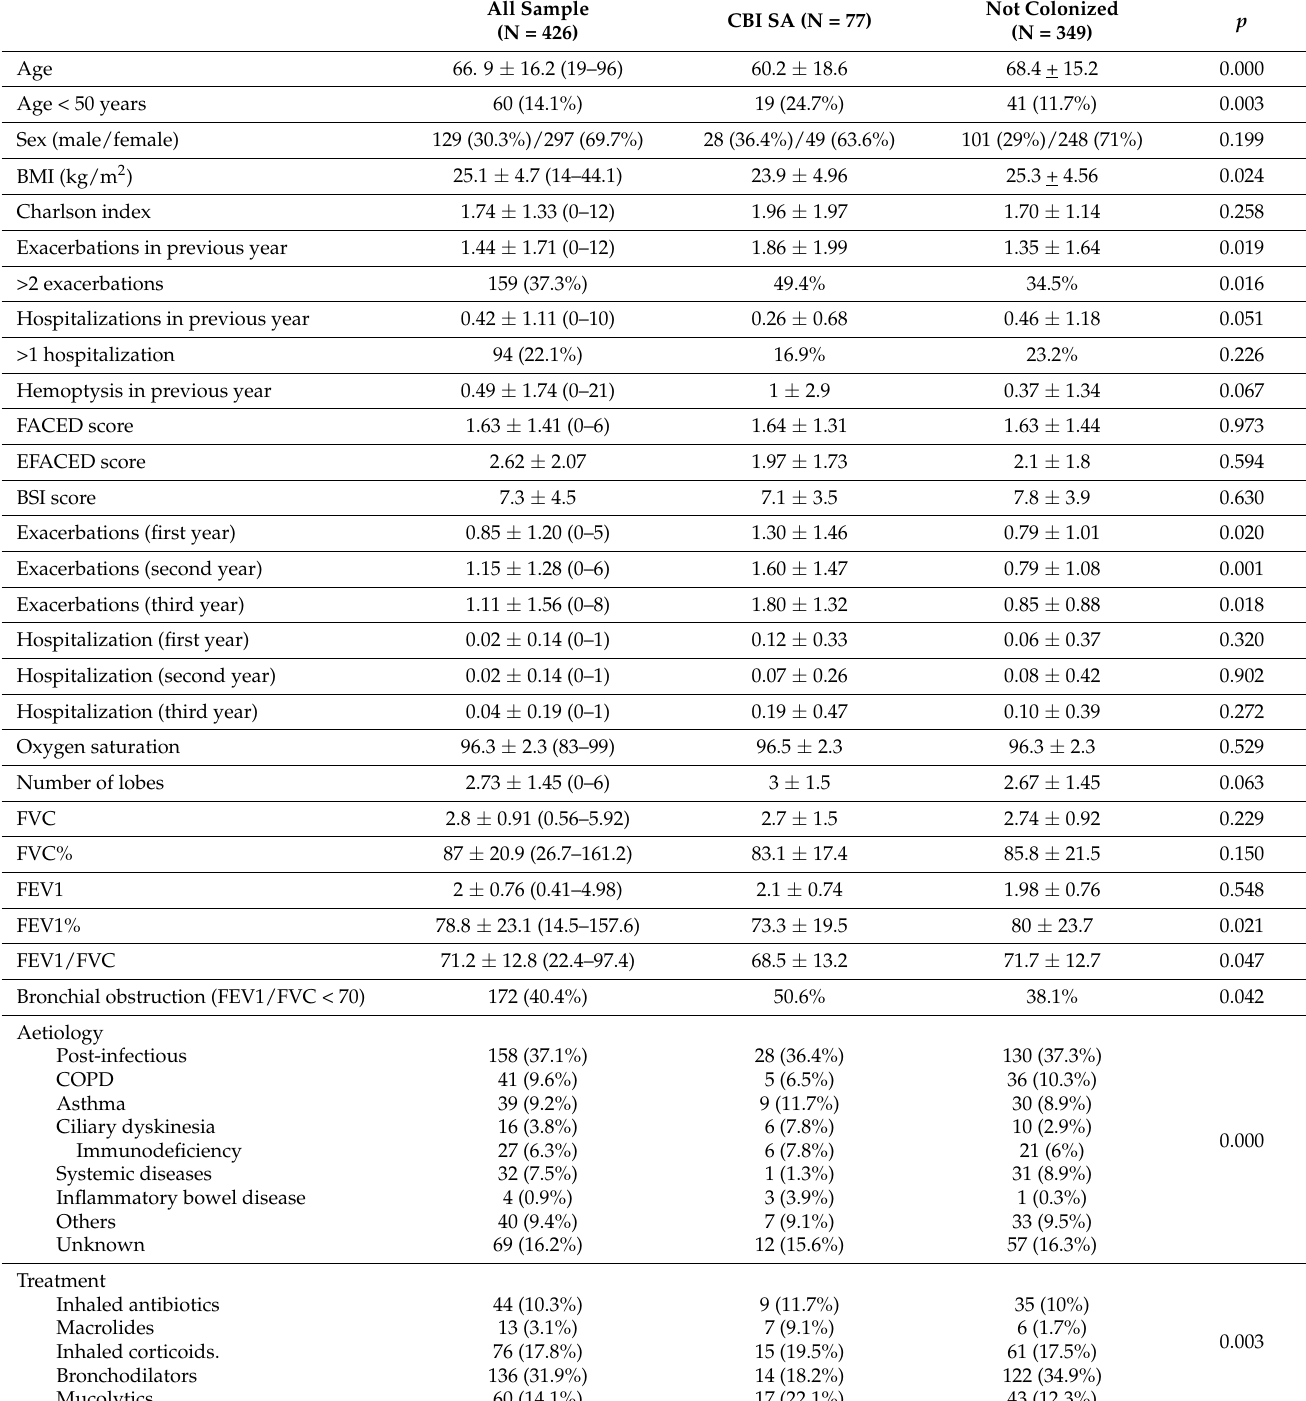
Table 1. General data of the sample and univariate analysis (comparison of patients with CBI due to SA and patients not colonized by